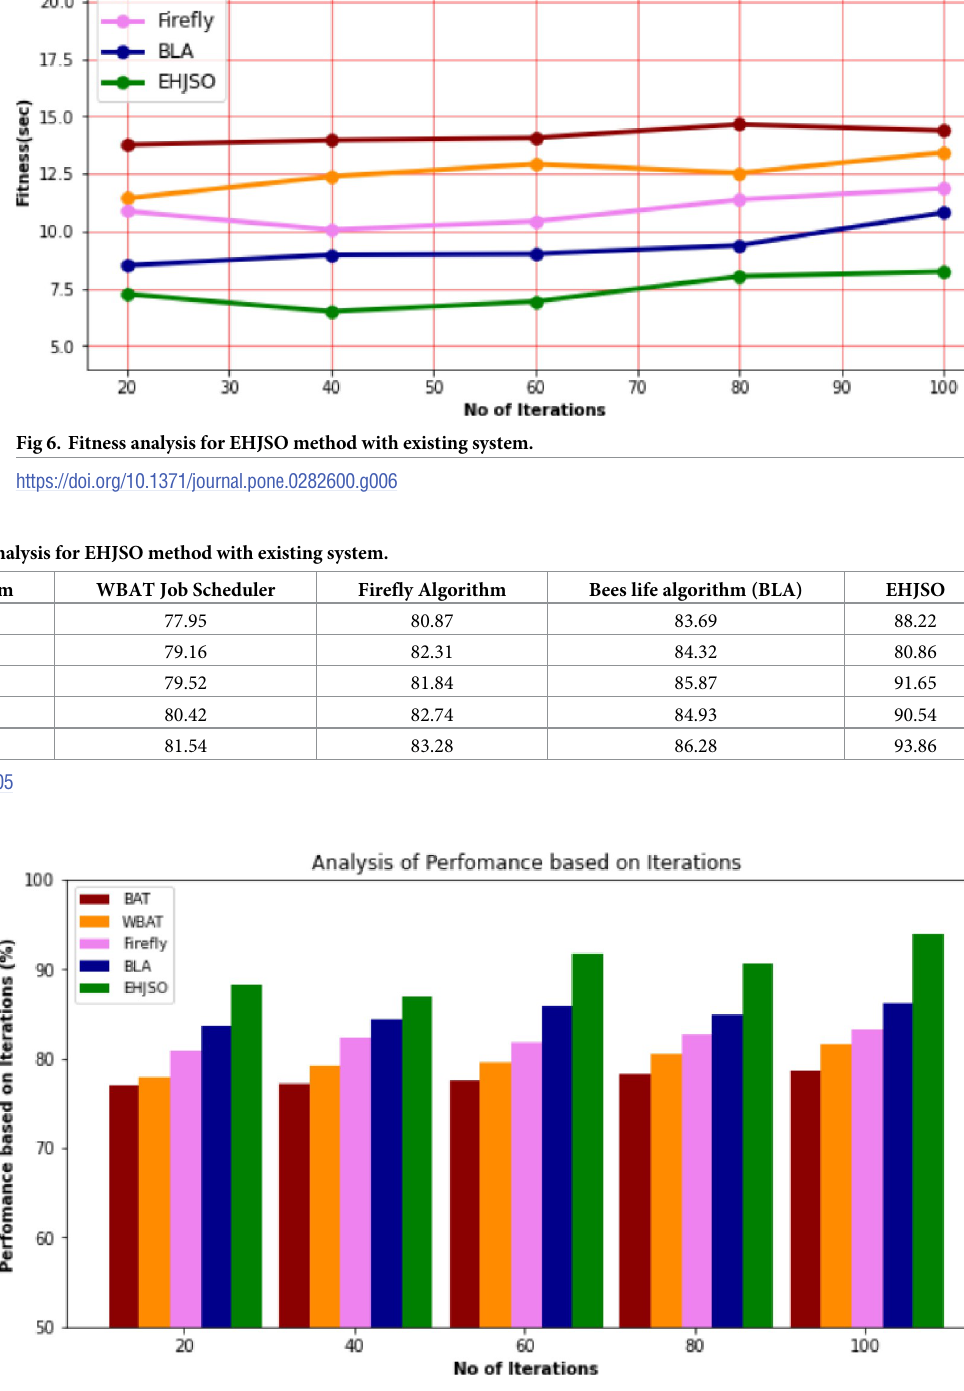
Fig 7. Performance based on Iterations analysis for EHJSO method with existing system.